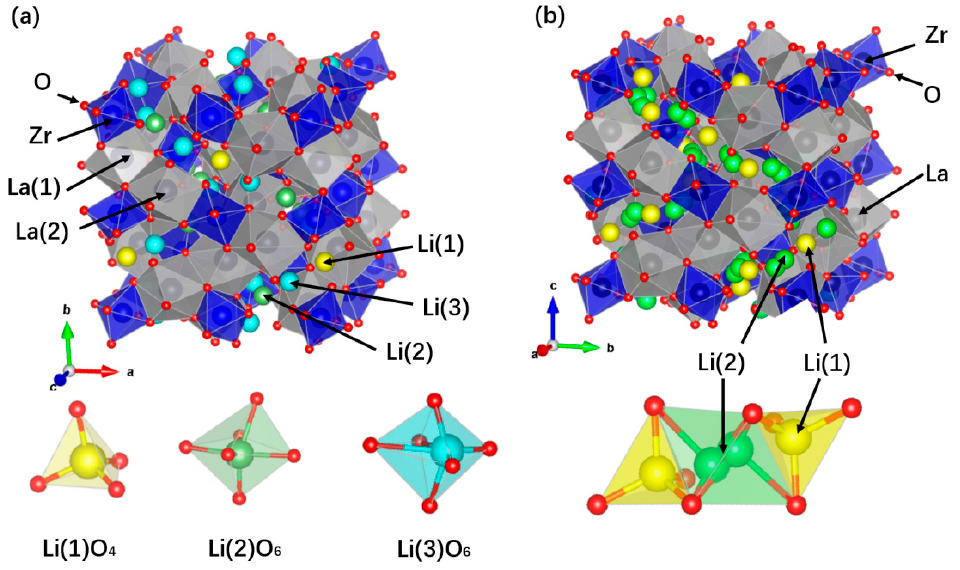
Figure 2. Crystal structure of ( a ) tetragonal LLZO and ( b ) cubic LLZO, and corresponding Li sites.